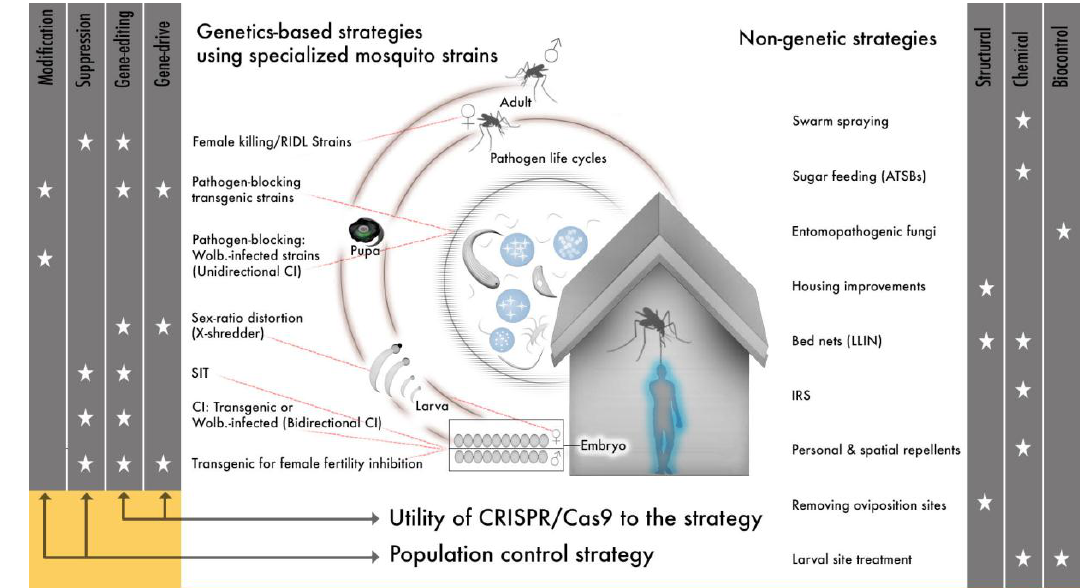
Figure 1. Genetic approaches to vector-borne disease offer a substantial complement to the existing tool-set. A scheme illustrating the contribution of specialized mosquito strains, including both transgenic and Wolbachia- infected mosquitoes, to vector control. Each strategy is categorized on the right as modification or suppression, whether the strategy can utilize Cas9 gene-editing or gene drives are indicated with a star. Whether a specific mosquito life-cycle stage or the pathogen life-cycle are targeted is indicated by a red line. The center schematic is a stylistic representation of vector-borne pathogens and is included to illustrate where specialized mosquito strains can be used to inhibit pathogen development in the mosquito. A summary of existing, non-genetic tools is to the left of the schematic. RIDL: release of insects carrying a dominant lethal, SIT: sterile insect technique, CI: cytoplasmic incompatibility, LLIN: long-lasting insecticide treated nets, IRS: indoor residual spraying, ATSB: attractive toxic sugar baits.